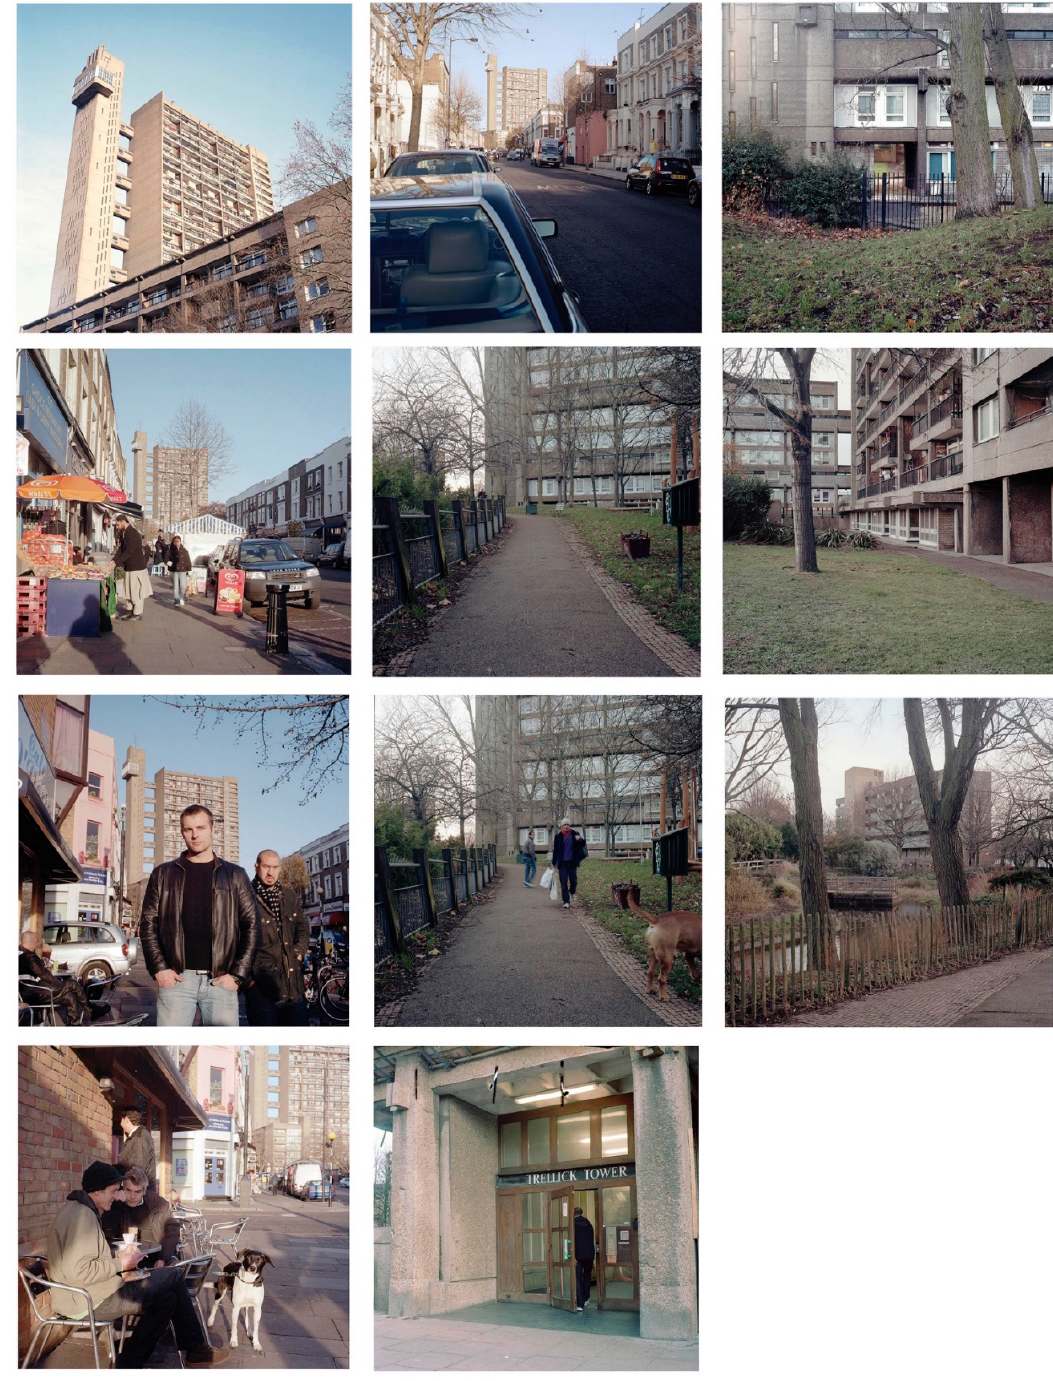
Figure 2. Anna Positano 2012, Trellick and Balfron Towers. Images courtesy of Anna Positano,